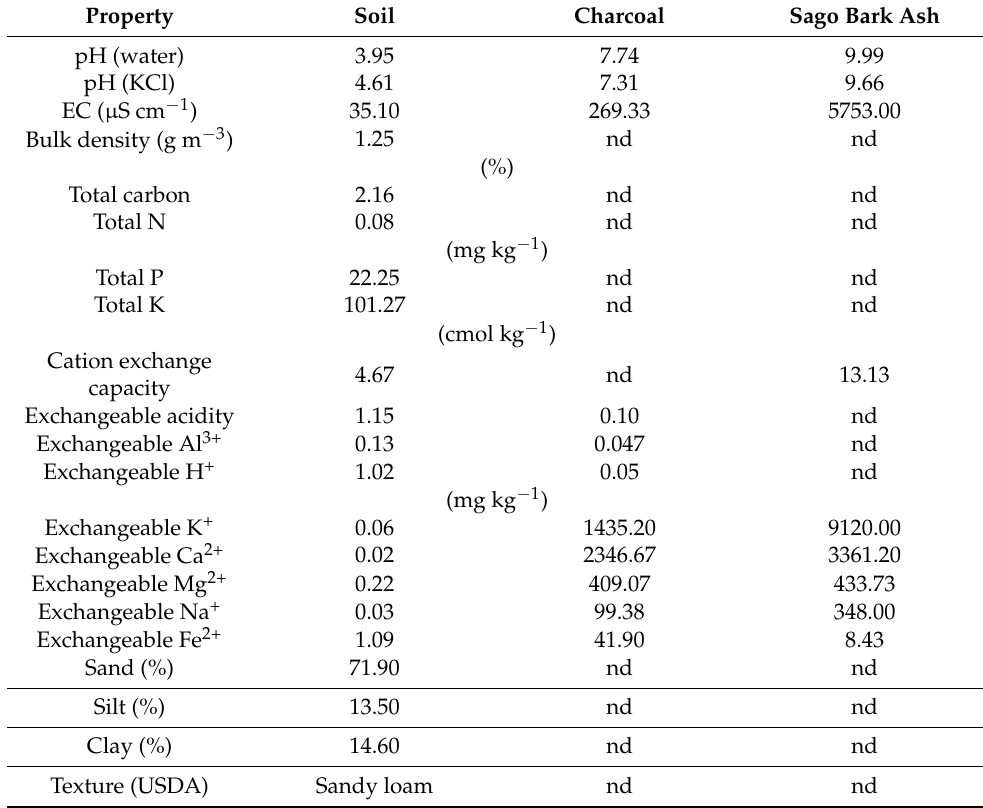
Table 1. Selected physical and chemical properties of Bekenu Series (Typic Paleudults) , charcoal, and sago bark ash used in the incubation